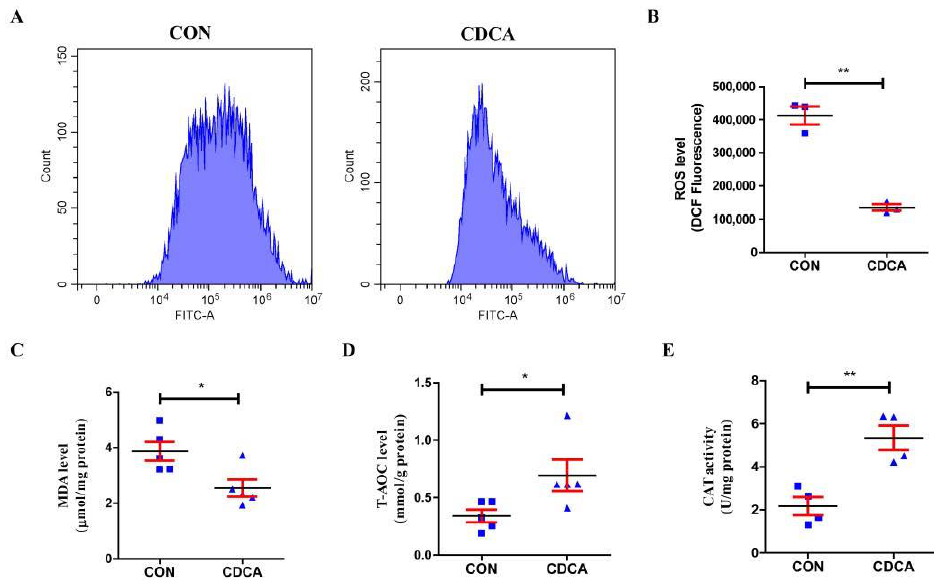
Figure 4. Effects of CDCA on oxidative stress and oxidation resistance of IPEC-J2 cells. The repre- sentative flow cytometry plots ( A ) of cell intracellular ROS level ( n = 3) ( B ); MDA level ( C ), T-AOC activity ( D ), and CAT activity ( E ) of IPEC-J2 cells treated with CDCA ( n = 5). Values are presented as mean ± SEM. * p < 0.05, ** p < 0.01 compared with the CON group. ROS, reactive oxygen species; MDA, malondialdehyde; T-AOC, total antioxidant capacity; CAT, catalase.